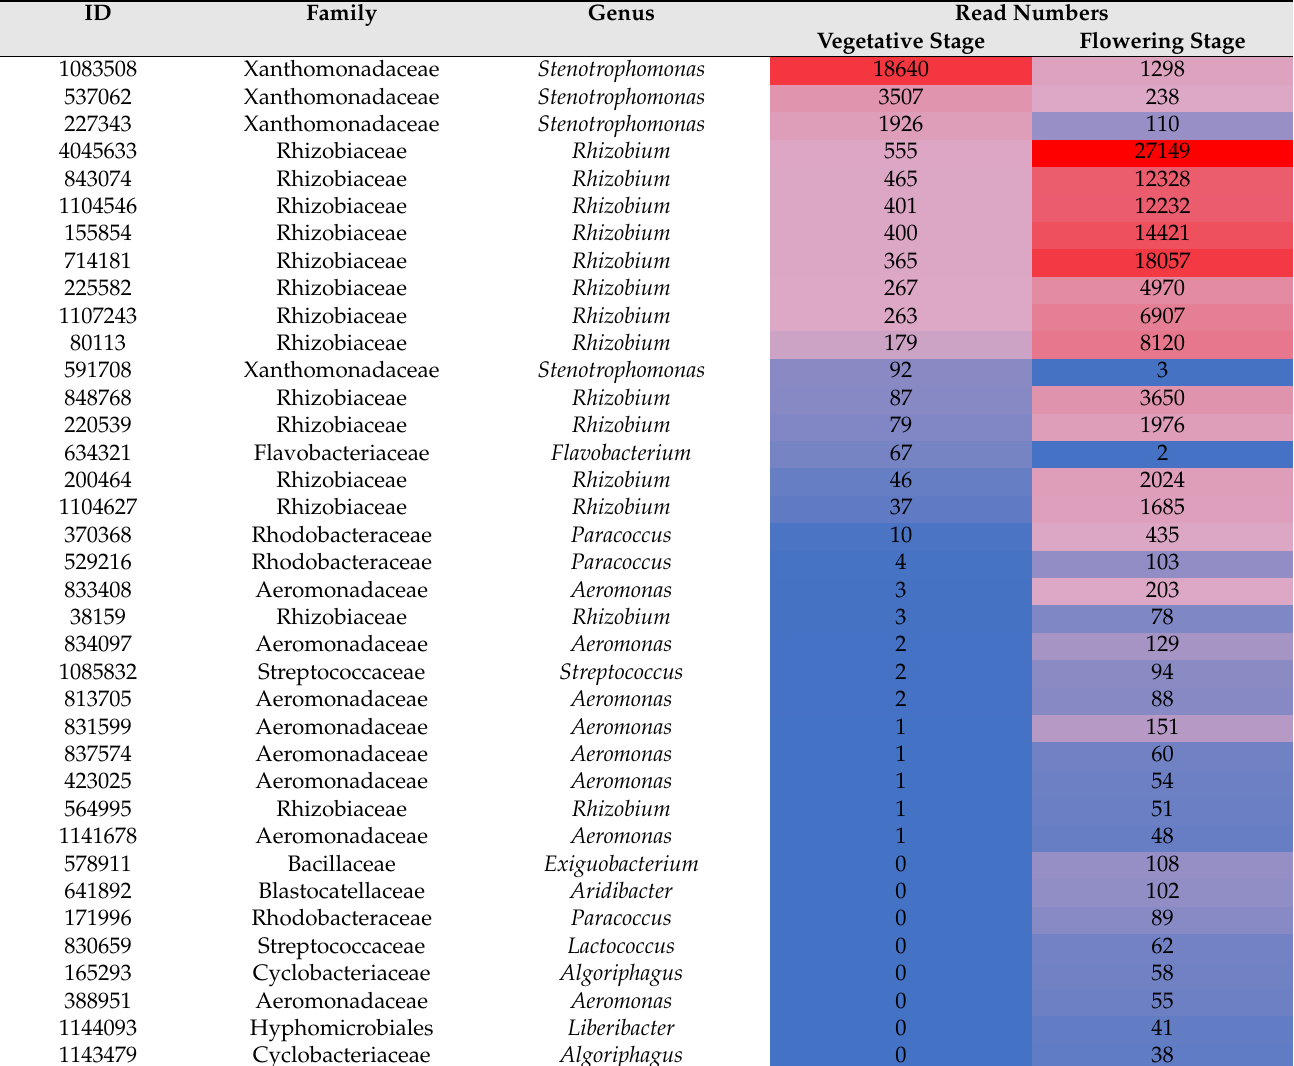
Table 2. Rhizosphere OTUs with differential abundances between the vegetative and the flowering stage 1